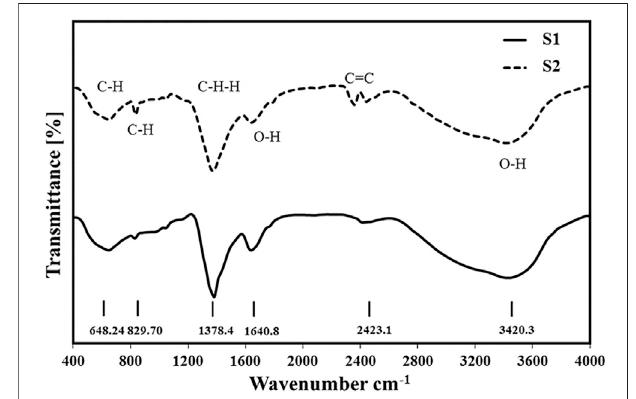
FIGURE 2 | The FT-IR spectrum of Al-MOFs with CA and Na 2 -CA, S1 and S2,